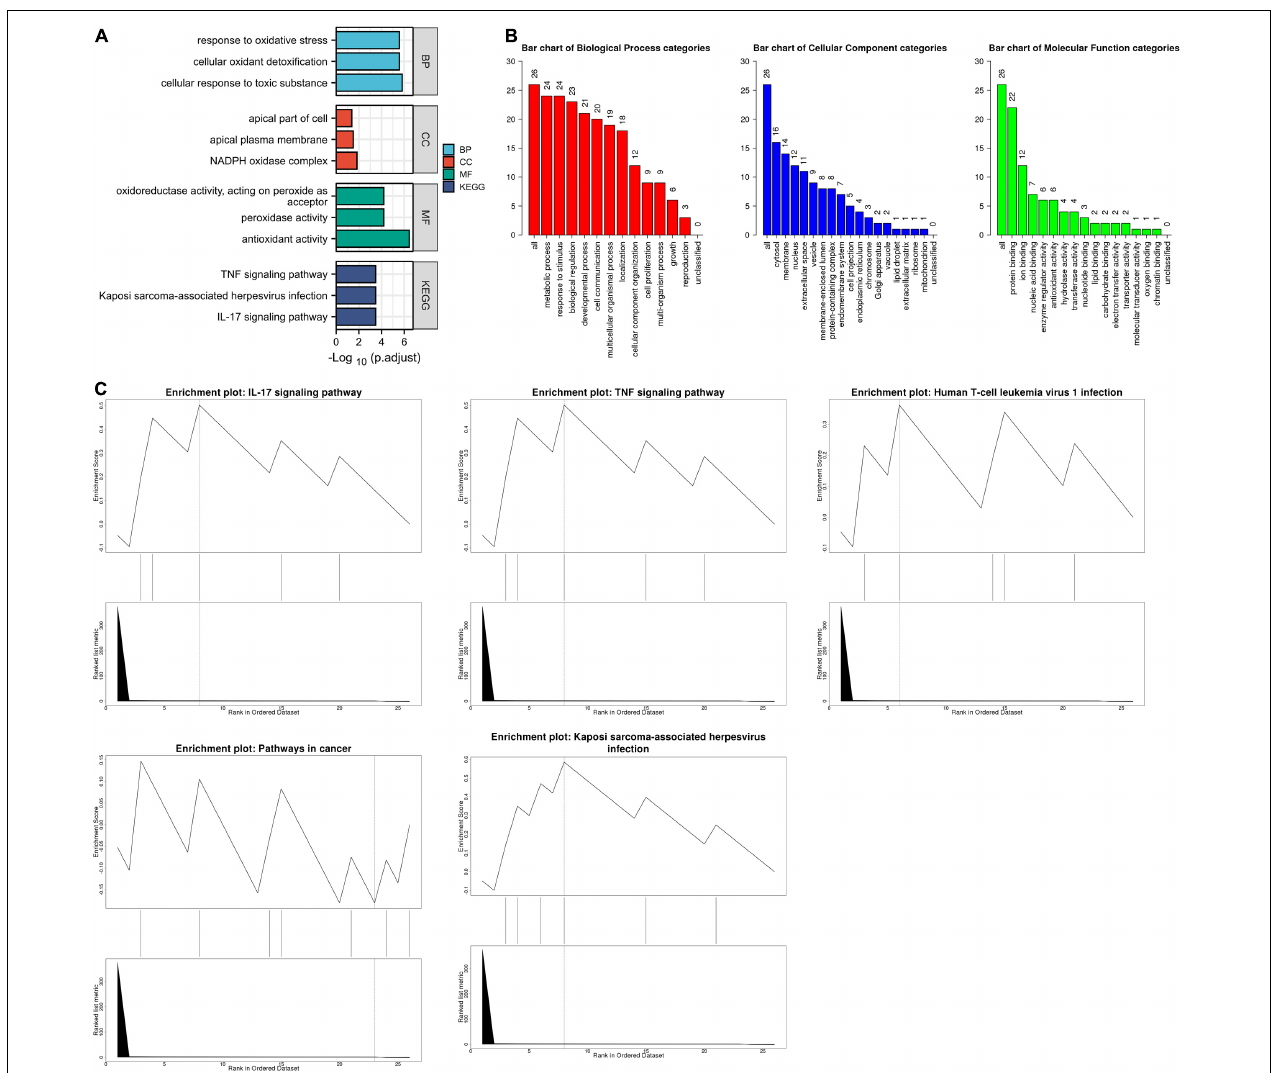
FIGURE 2 | The enrichment pathway analysis of ferroptosis-related DEGs. (A) The significant GO and KEGG pathways enriched by ferroptosis-related DEGs using the Xiantao Website. (B) The GO enrichment pathway analysis of ferroptosis-related DEGs using WebGestalt. (C) The Gene Set Enrichment Analysis of ferroptosis-related DEGs using